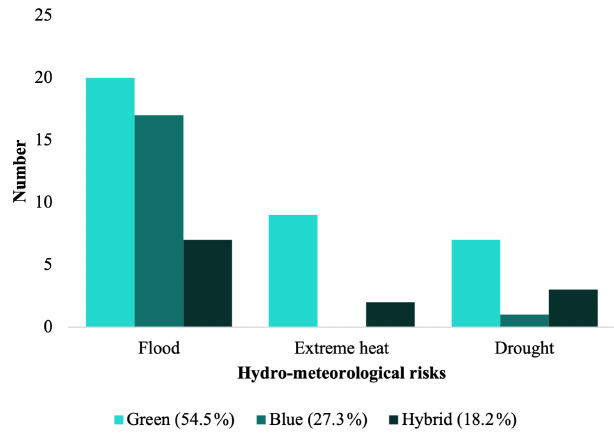
Figure 6. The link between NBS type and risks